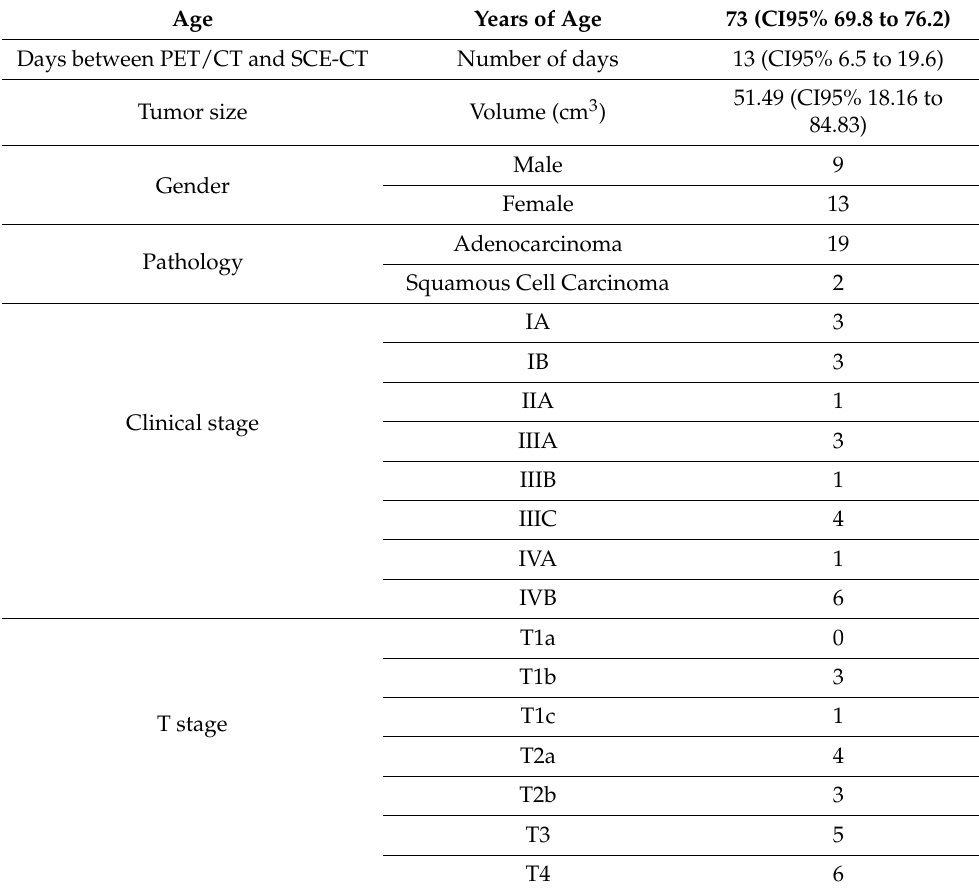
Table 1. Patient demographics including age, sex, days between PET and SCE-CT scans, tumor size, pathology, clinical stage and T